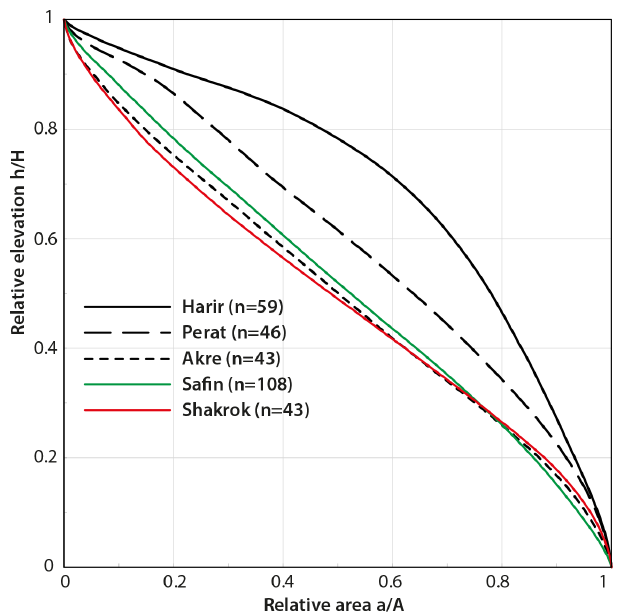
Figure 13. Total weighted mean hypsometric curves for drainage basin within the studied anticlines as compared to those of the Shakrok and Safin anticlines. The Harir’s curve is more convex than those of both Shakrok and Safin. n is the number of basins used in the calculation of the hypsometric curve for each anticline.